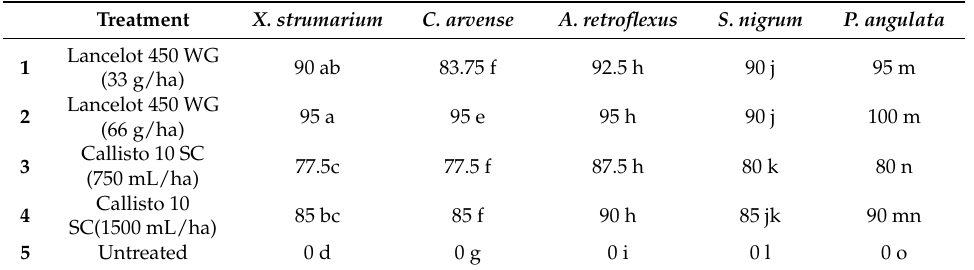
Table 5. Efficacy assessment (%) of the several treatments on broadleaf weeds at 28 DAT.